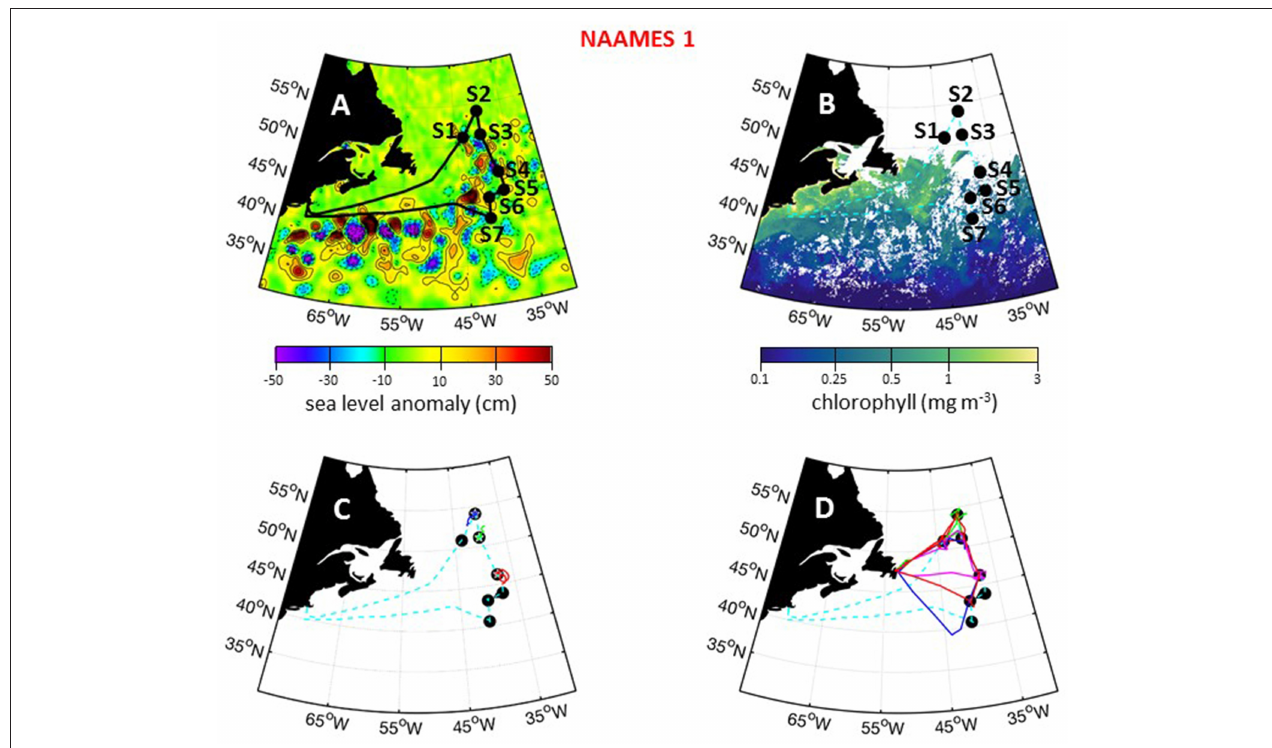
FIGURE 6 | NAAMES 1 primary stations, autonomous floats, and flight tracks. (A) Black line = ship transit. Labeled black circles = primary sampling stations. Background color = sea surface height anomalies highlighting anticyclonic and cyclonic mesoscale eddies in red and blue/purple, respectively. (B) Climatological surface chlorophyll concentrations for the NAAMES 1 period from satellite ocean color measurements. (C) Float trajectories up to 30 days following the campaign. Star = float deployment site. (D) C-130 flight paths for the NAAMES 1 airborne campaign. Broken cyan line in (B–D) = ship